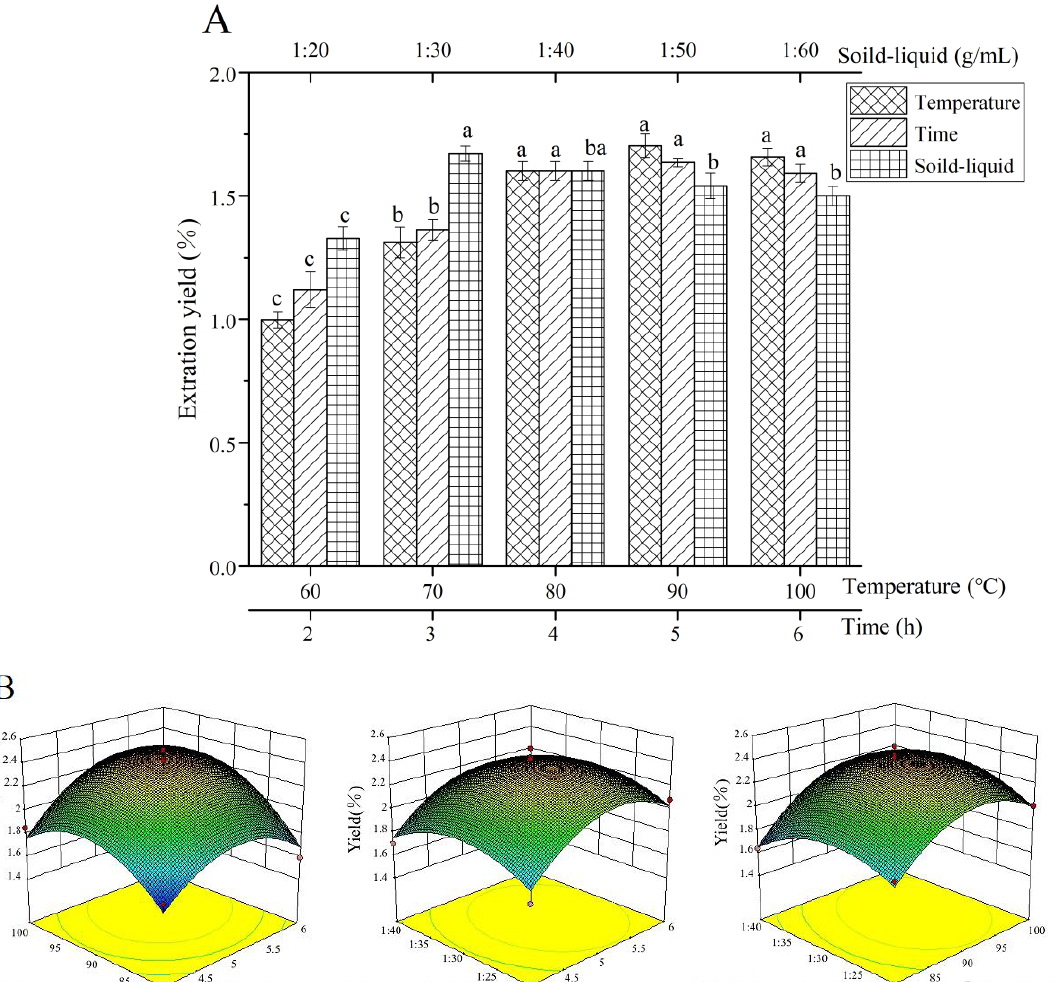
Figure 1. Results of single factor and RSM, A: single factor, B: RSM. Different lower-case letters were different significantly ( p < 0.05).